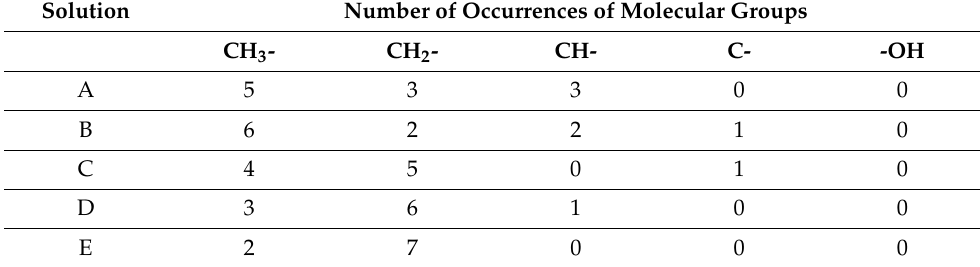
Table 4. List of solutions in terms of molecular groups.